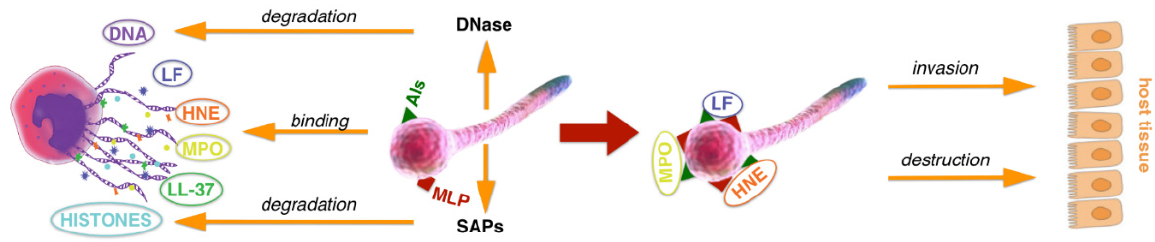
Figure 10. Proposed mechanisms of the possible usage of C. albicans adhesins and secreted enzymes in the invasion and defense of fungal cells against netosis. Secreted enzymes: DNase, endonucleases used in neutrophil DNA degradation; SAPs – secreted aspartic proteases degrading host proteins and antimicrobial peptides. Surface proteins: Als, adhesins of a family of agglutinin-like sequence proteins; MLP, moonlighting proteins, cytosolic enzymes with additional surface adhesive properties, including among others Eno1 (enolase), Gpm1 (phosphoglycerate mutase), Tpi1 (triosephosphate isomerase). Host proteins identified to be bound to C. albicans cells during NET release by neutrophils: HNE, neutrophil elastase; MPO, myeloperoxidase; LF, lactotransferrin; LL-37, an antimicrobial peptide derived from cathelicidin; HISTONES: H2, H3,